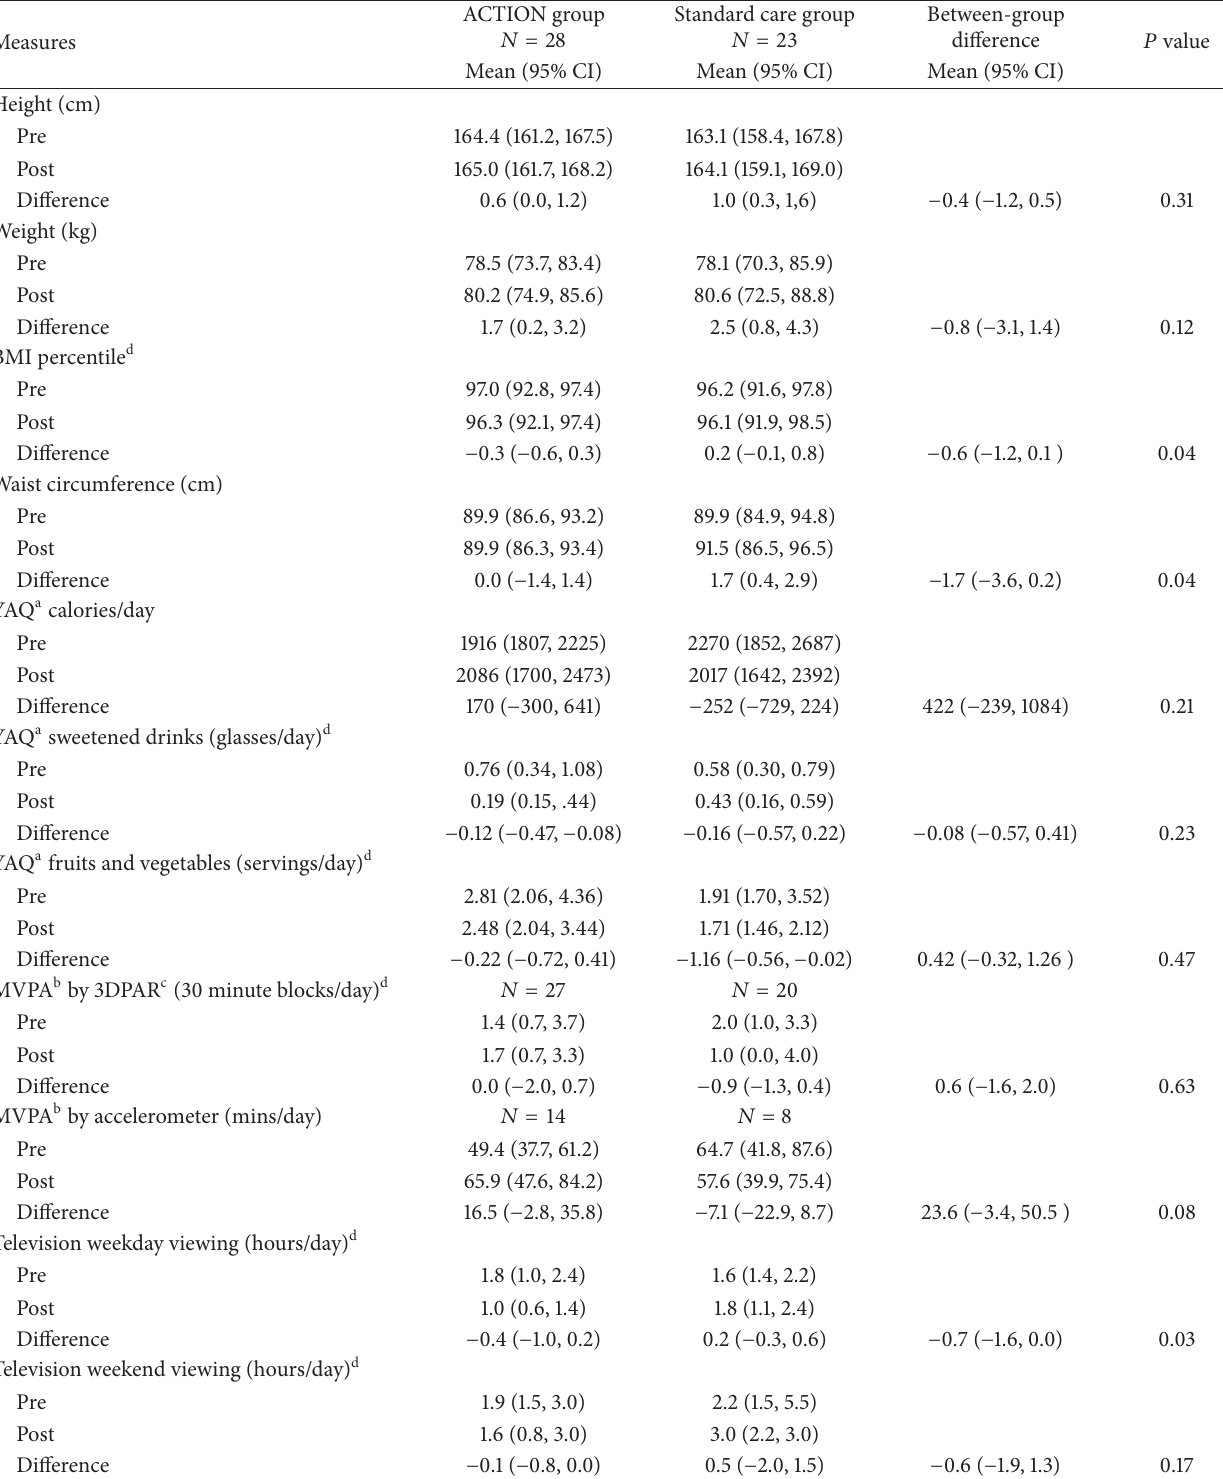
Table 4: Comparison of anthropometric and behavioral changes between ACTION and standard care